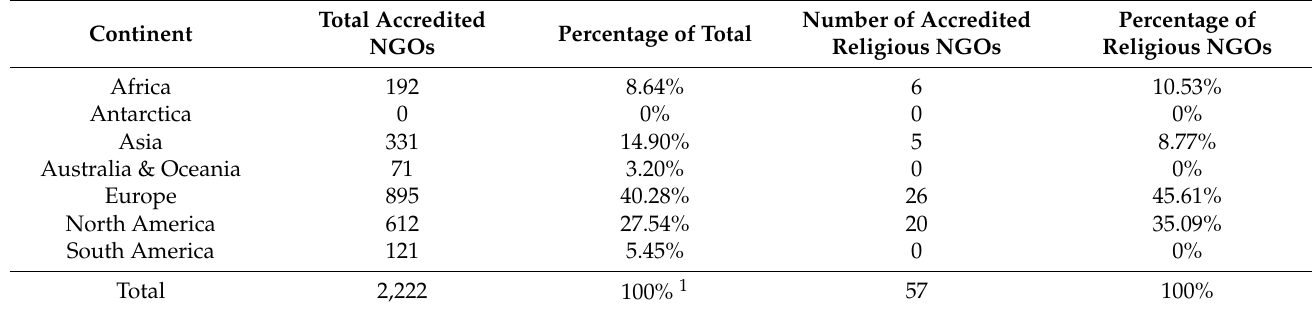
Table 4. Geographic distribution of UNFCCC-accredited